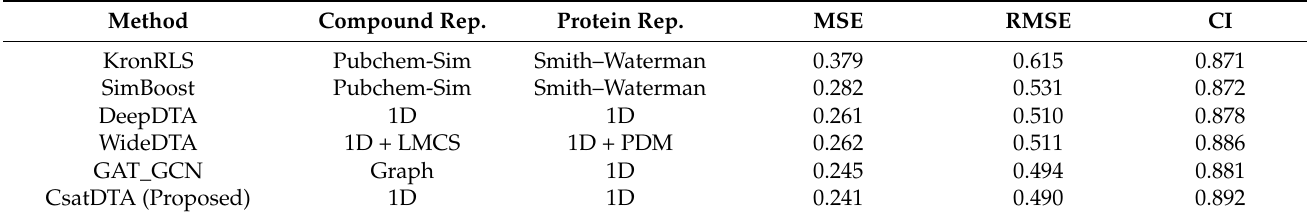
Table 3. Performance on the Davis dataset in terms of